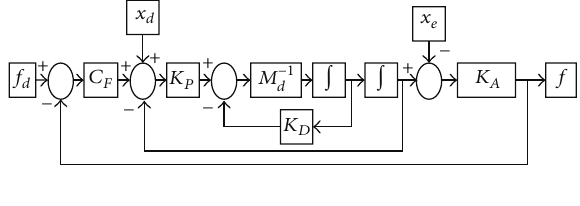
Figure 16: Classical force-position control scheme [1].